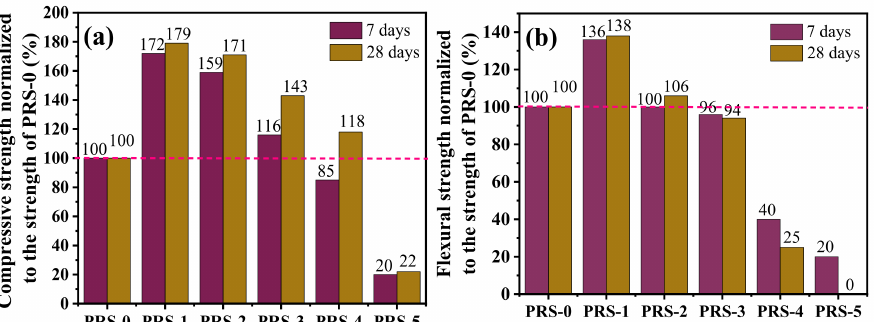
Figure 11. ( a ) Compressive strengths normalized to the strength of RS-0; ( b ) flexural strengths normalized to the strength of RS-0.